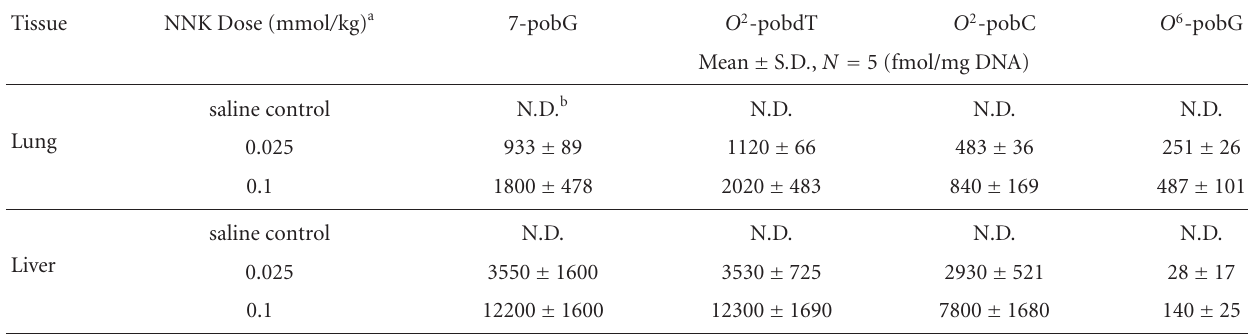
Table 1: Adduct levels in NNK-treated rats